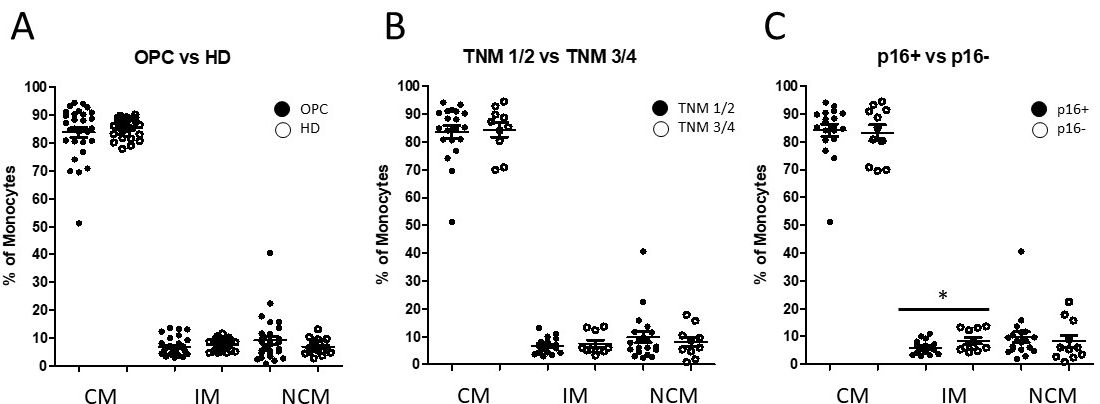
Figure 1. Flow cytometric analysis of CD14- and CD16-characterized monocyte subsets. ( A ) Whole- blood analysis revealed similar median abundances of classical monocytes (CMs), intermediate monocytes (IMs), and nonclassical monocytes (NCMs) in oropharyngeal cancer patients ( n = 32) compared with healthy donors ( n = 25), but much stronger dispersions of monocyte subset distributions in cancer patients. ( B ) No significant alterations in the monocyte subset composition were found between patients with TNM1/2 and the cohort with TNM3/4. ( C ) Subdivision with regard to the HPV status (p16 + vs. p16 − ) revealed no significant differences in classical and nonclassical monocyte compositions, but slightly significantly increased levels of intermediate monocytes in p16 − negative oropharyngeal cancer patients. * p < 0.05.